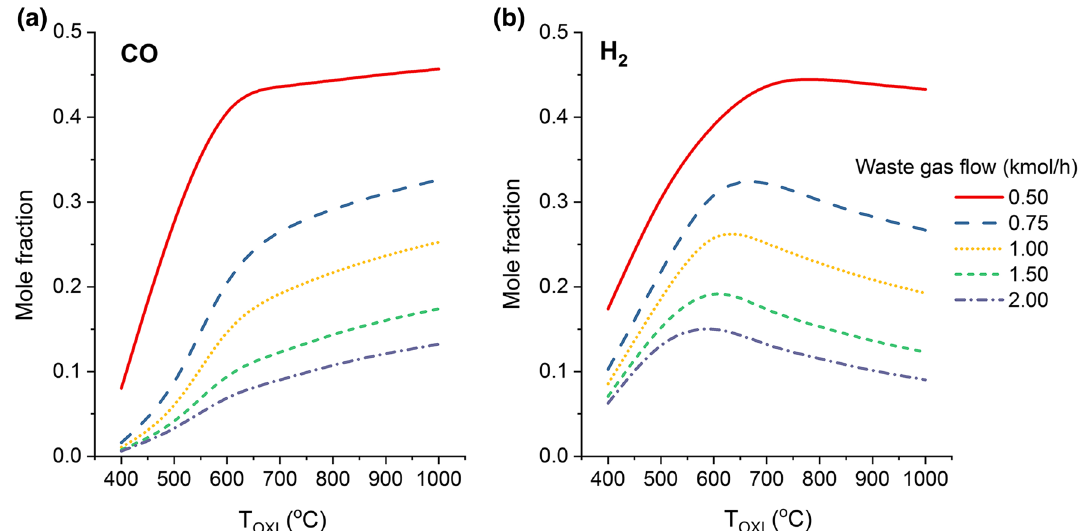
Fig. 6 Impact of the variation of the waste gas (equimolar mixture of CO as the molar fraction of the product gas of the oxidation